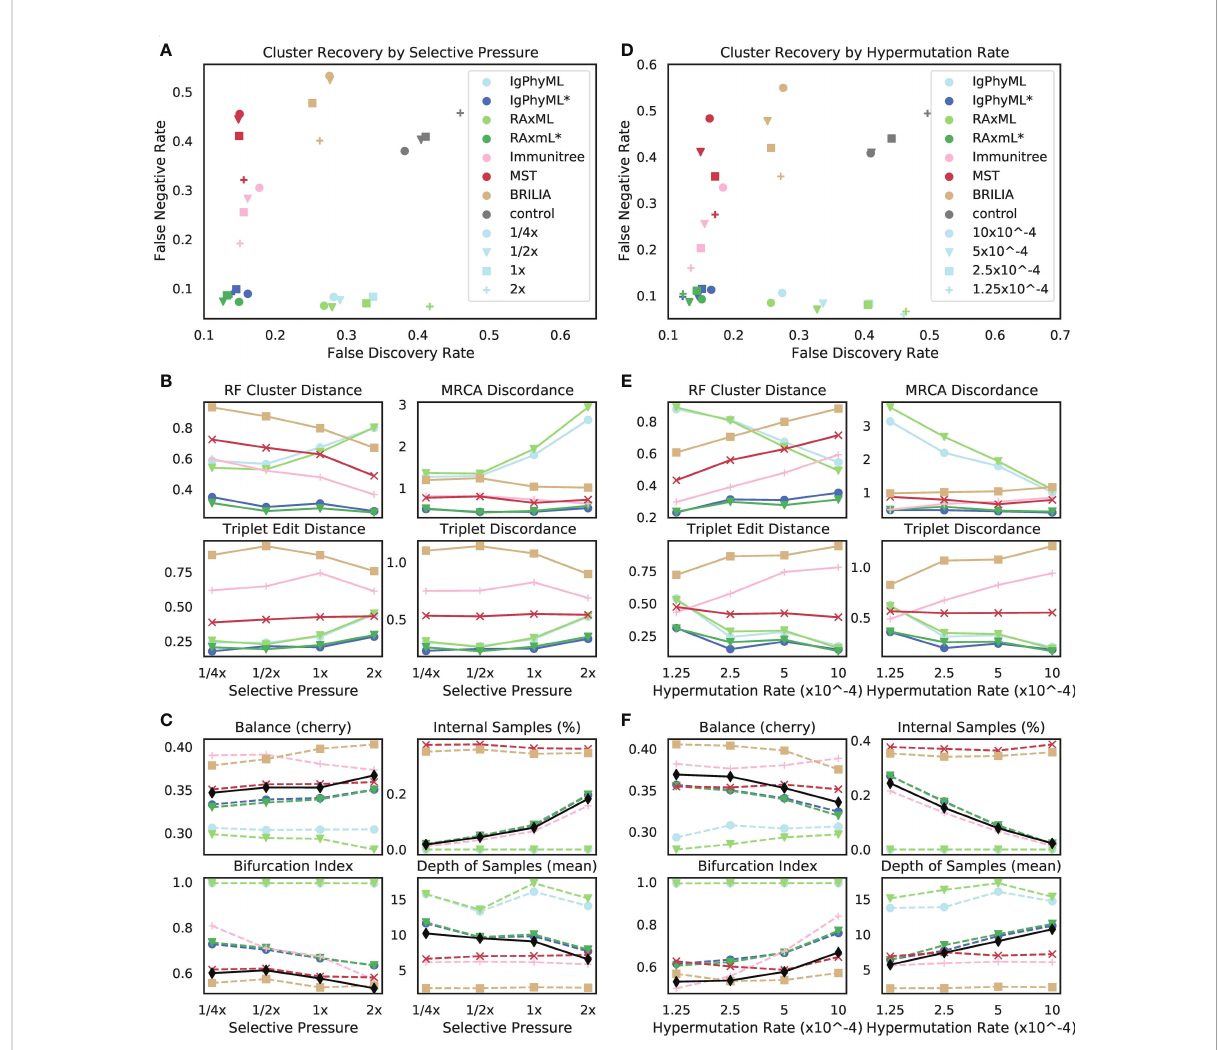
FIGURE 7 (A-C) Impact of selective pressure A and (D-F) mutation rate µ on (A, B, D, E) tree inference error and (C, F) tree properties. We measure tree error by (A, D) FDR, FNR, (B, E) Robinson-Foulds cluster distance (RF), MRCA discordance (MD), triplet edit distance (TED), and triplet discordance (TD). Tree errors and tree properties are averaged over 30 replicates. (C, F) We show properties of true (black) and reconstructed trees. µ = 5 × 10 − 5 in (A-C) and A = 0.1 in (D-F) , which are all default values. *: contracted